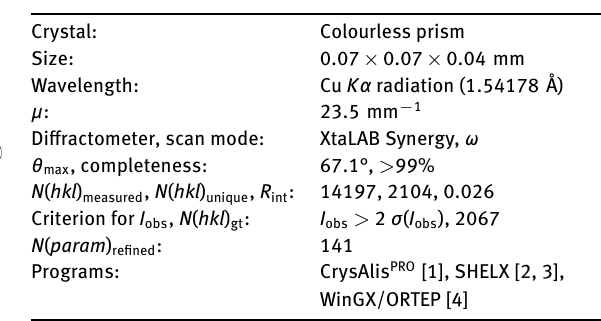
Table 1: Data collection and handling.